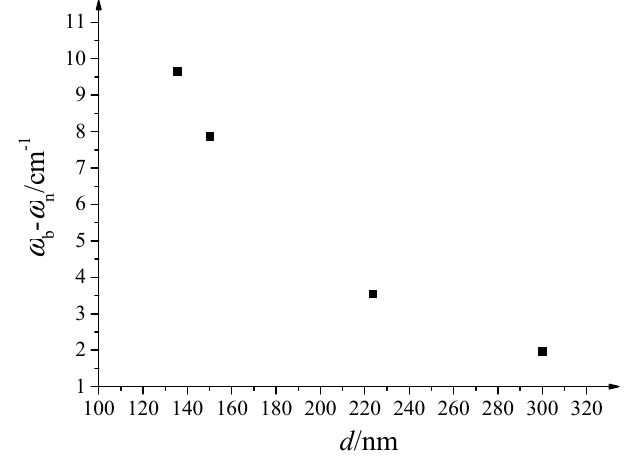
Figure 8. The relationship curve between ω b - ω n and d.